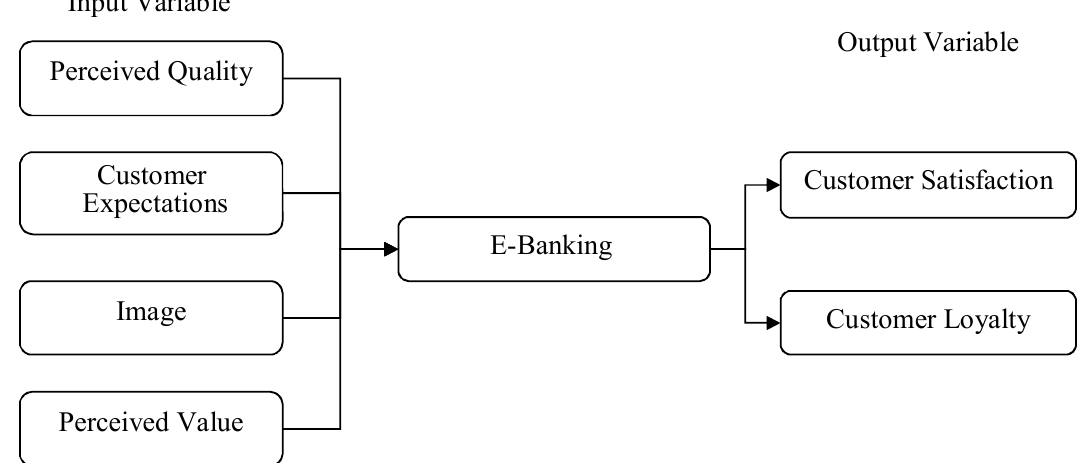
Fig. 1. Fuzzy DEA model related to customer satisfaction